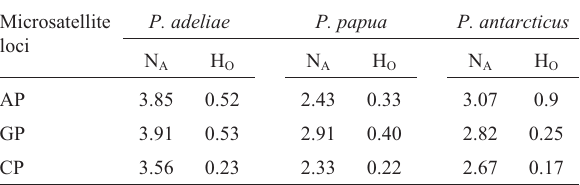
Table 3 - Mean number of alleles per marker ( N A ) and observed hetero- zygosity ( H o ) for microsatellite loci isolated from all three species. (AP: P. adeliae, GP: P. papua and CP: P. antarcticus